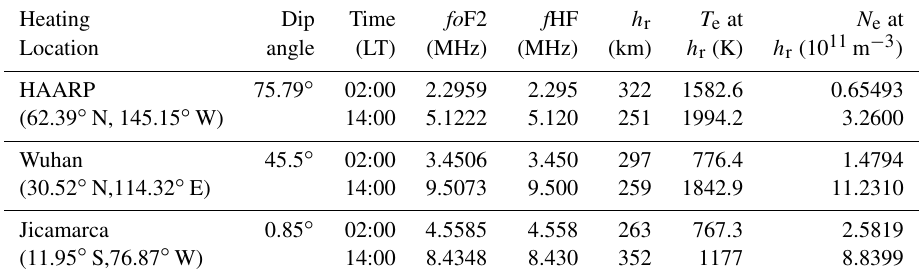
Table 1. Heating parameters used in the model. Heating Dip Time fo F2 f HF h r T e at N e at Location angle (LT) (MHz) (MHz) (km) h r (K) h r (10 11 m − 3 ) HAARP 75.79 ◦ 02:00